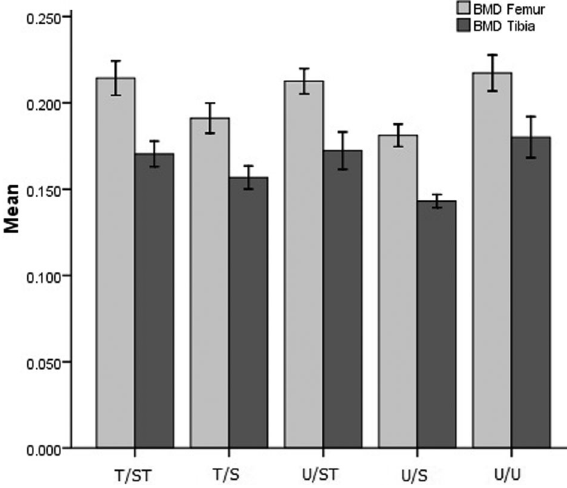
Figure 5. BMD (bone mineral density; g/cm 2 ) of the experimental groups. T/ST: trained/suspended + trained rats; T/S: trained/ suspended rats; U/ST: untrained/suspended + trained rats; U/S: untrained/suspended rats; U/U: untrained/unrestricted. Results are reported as mean and 95%CI for n=10 rats per